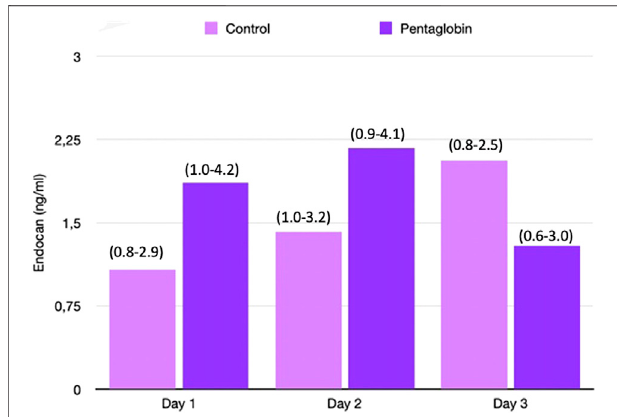
FIGURE 4 | Comparison of Endocan changes over time between Pentaglobin and control groups by linear mixed models ( p (cid:1) 0.38). The height of bars represents the median values and the numbers in brackets the corresponding interquartile range of Endocan in Pentaglobin treated patients and in controls in the fi rst 3 days from ICU admission and septic shock. Pentaglobin therapy seems to restrain a regular upward trend of the Endocan levels, which instead characterizes the fi rst 3 days of septic patients who were only on conventional therapy. The between-groups comparison over time was performed by linear mixed models and resulted to be not signi fi cant ( p (cid:1) 0.38). See text for more details.